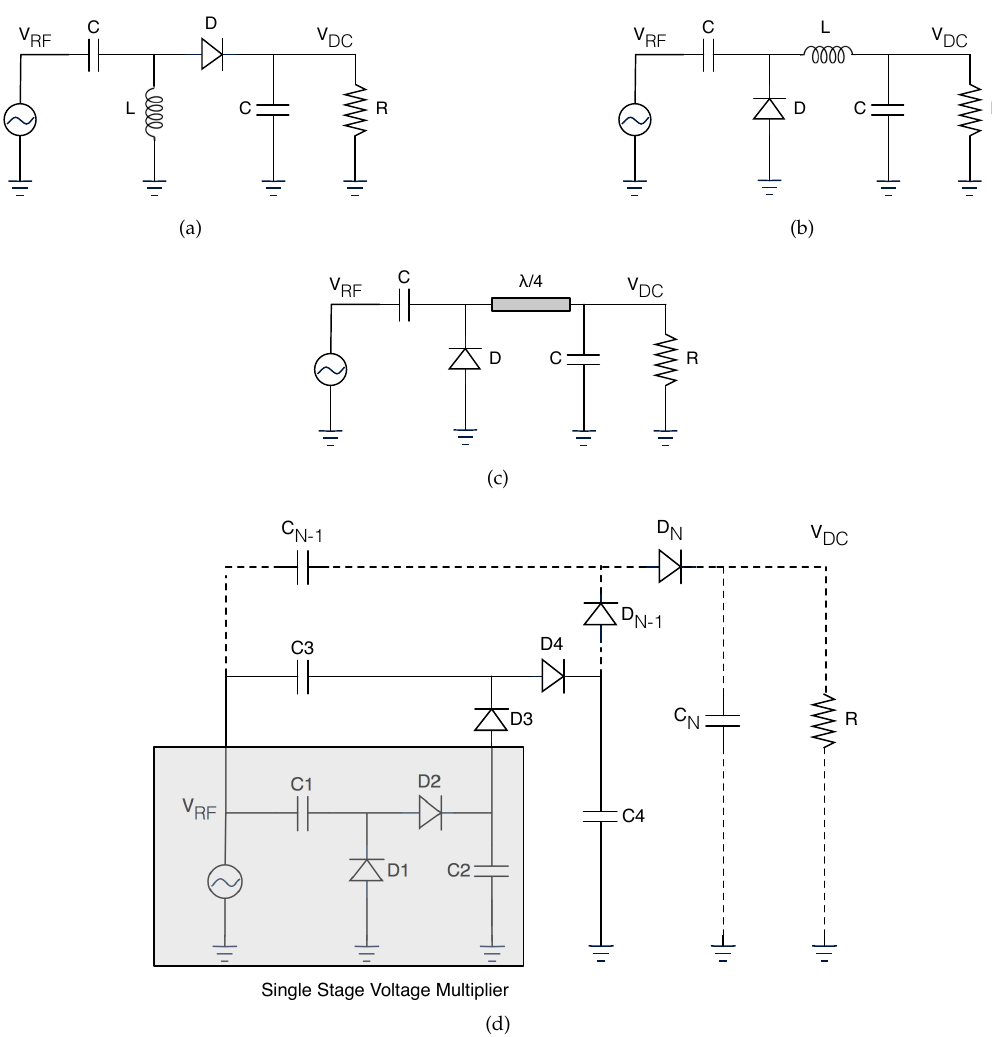
Figure 6. Different rectifier topologies. ( a ) Series diode rectifier. ( b ) Shunt diode rectifier. ( c ) Shunt diode with λ /4 stub. ( d ) N-stage Dickson voltage multiplier.